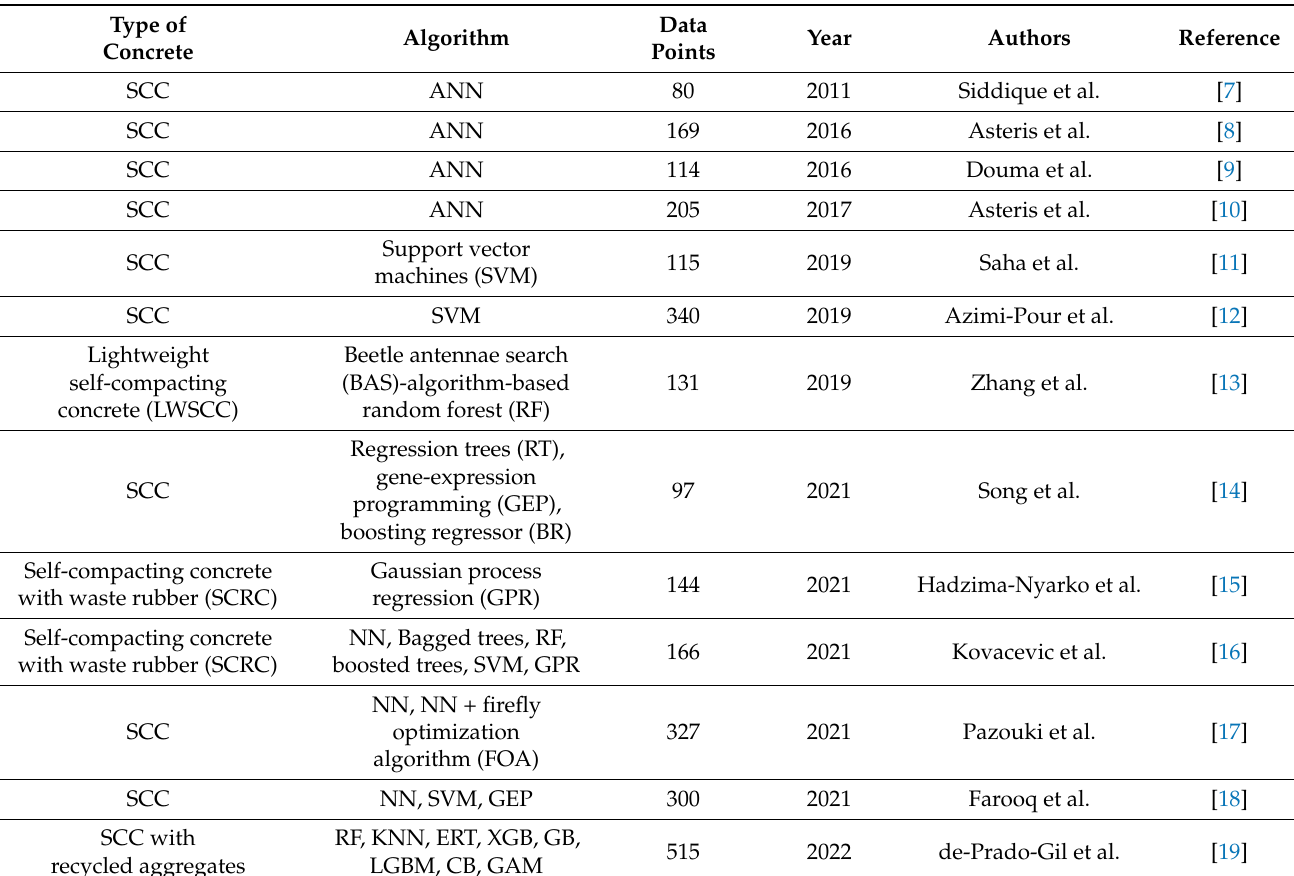
Table 1. Review of the application of ML algorithms in the development of compressive strength (CS) prediction models in self-compacting concrete